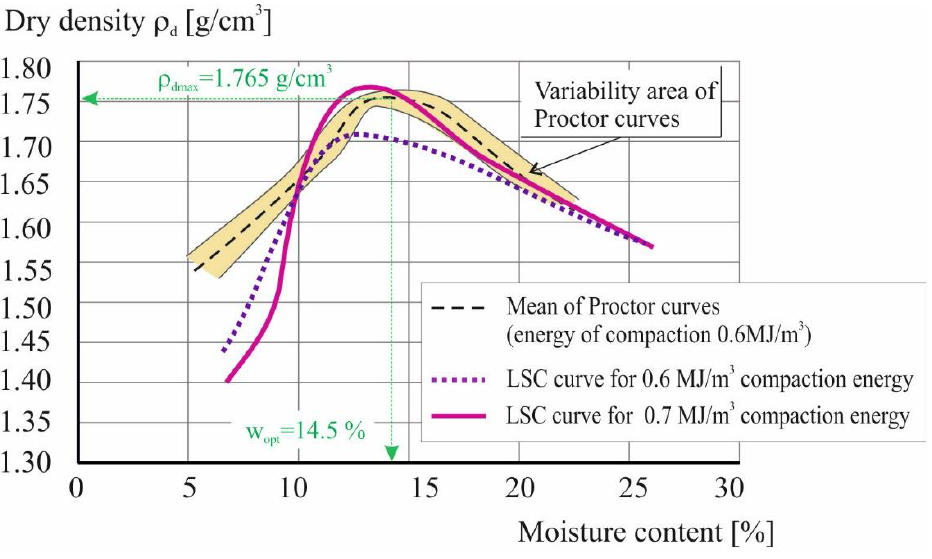
Figure 9. Soil compaction curves in standard Proctor test and laboratory soil compactor.